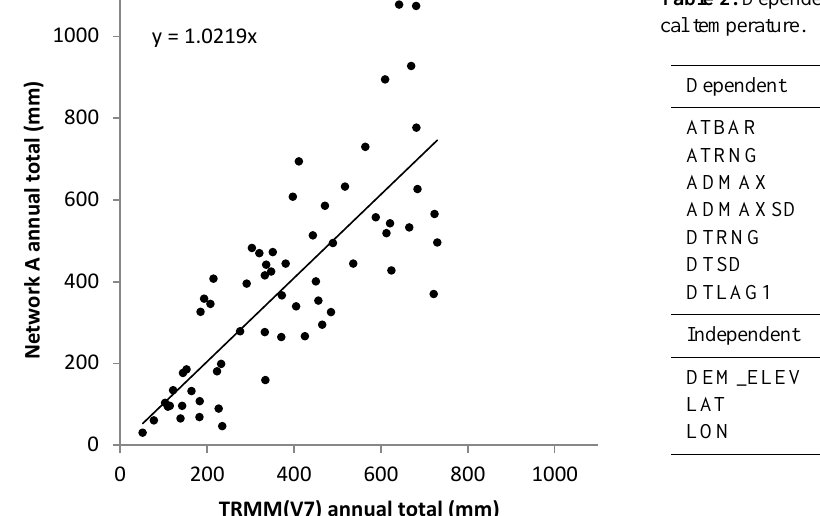
Table 2. Dependent and independent variables used to estimate lo- cal